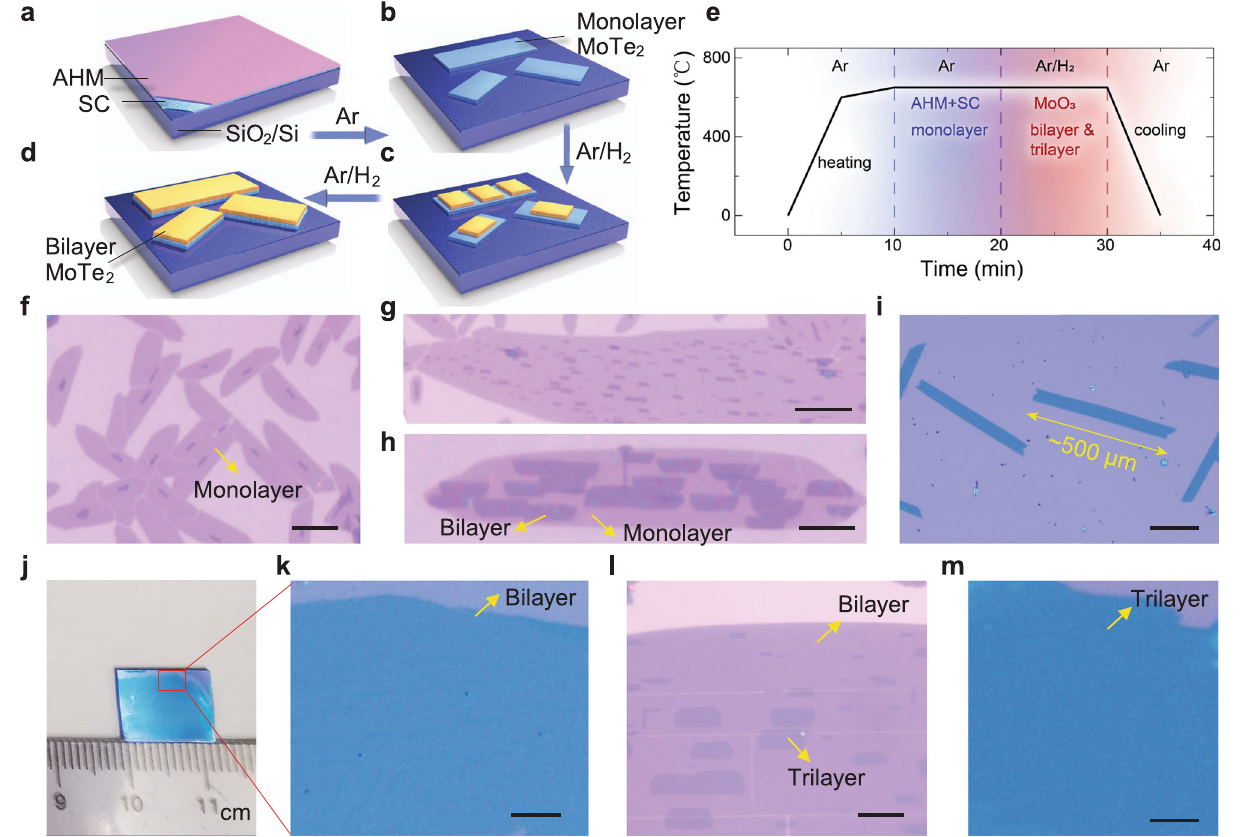
Fig. 1 | Layer-by-layer growth of centimetre-scale MoTe 2 fi lms. a – e , Schematic ( a - d ) and growth parameters ( e ) for the growth of MoTe 2 single crystals. The temperature pro fi le in e indicates the temperature at SiO 2 /Si substrates. The blue and red shaded areas represented the growth stage for monolayer, bilayer, and trilayergrowth,respectively.AHMandSCin a and e representedtheMoprecursor (ammonium molybdate tetrahydrate, (NH 4 ) 6 Mo 7 O 24 ·4H 2 O) and growth promotor (sodiumchlorate),respectively,whichwereusedforthemonolayerMoTe 2 growth. f – i Optical images of MoTe 2 single crystals at different growth stages: monolayer